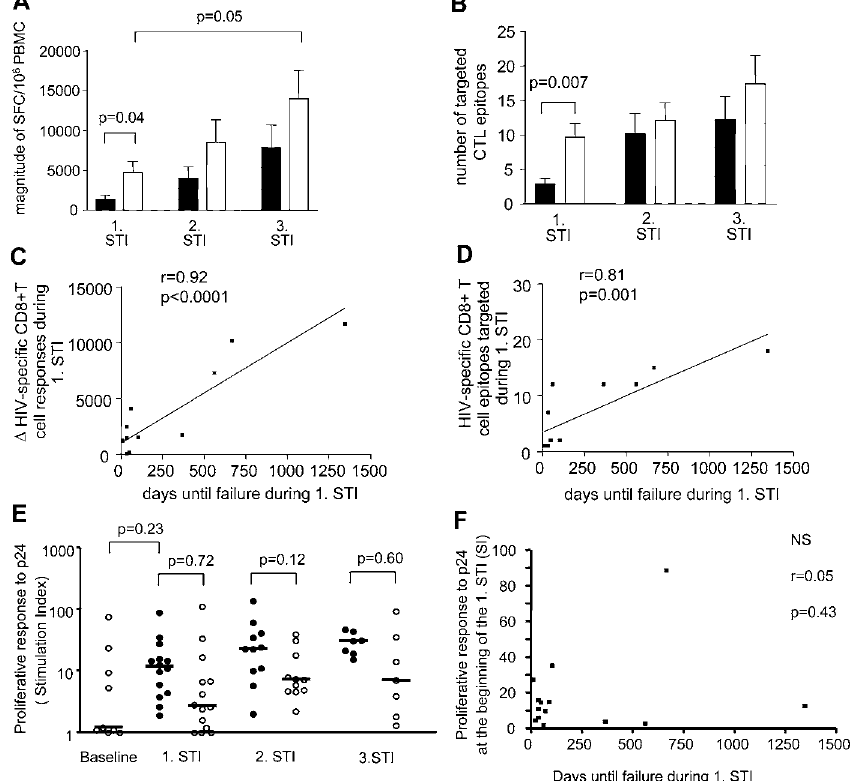
Figure 3. Evolution of HIV-1-Specific CD4 þ and CD8 þ T Cell Responses during STI (A–D) Magnitude and breadth of increase of HIV-specific CD8 þ T cells during supervised treatment interruptions. (A and B) Magnitude (A) and breadth (B) of HIV-specific CD8 þ responses at the first day of treatment interruption (black bars) and at the last day off therapy (white bars). Data represent the mean and standard deviation. (C and D) Correlation between the increase of the magnitude (C) or breadth (D) of CD8 þ T cell responses and the time off therapy during the first treatment interruption. (E and F) Evolution of CD4 þ T helper cell responses during supervised treatment interruptions. (E) Magnitude of CD4 T helper cell responses at baseline and at the first day of treatment interruption (closed circles) and last day off therapy (open circles). Horizontal bars correspond to median values. An stimulation index greater than five was considered significant. (F) Correlation between the magnitude of p24-specific lymphocyte proliferative responses at the beginning of the first treatment interruption and the time patients were able to remain off therapy during the subsequent STI. DOI: